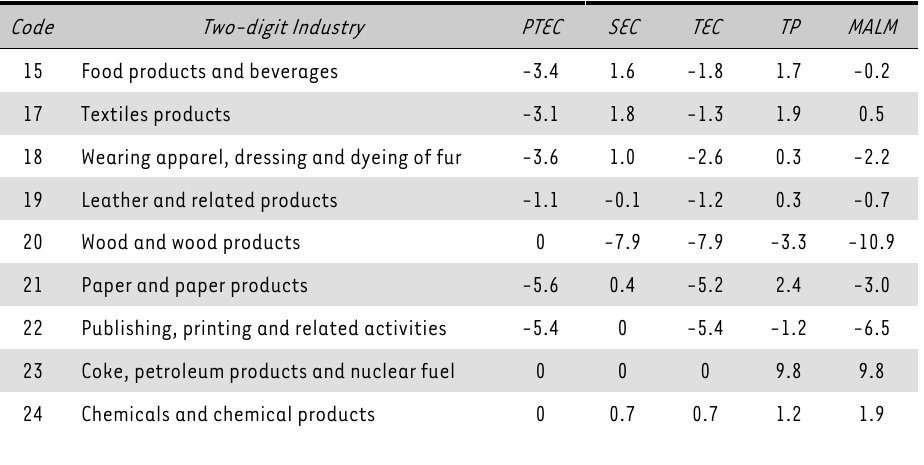
DEA Results: Average annual changes in the Indian manufacturing